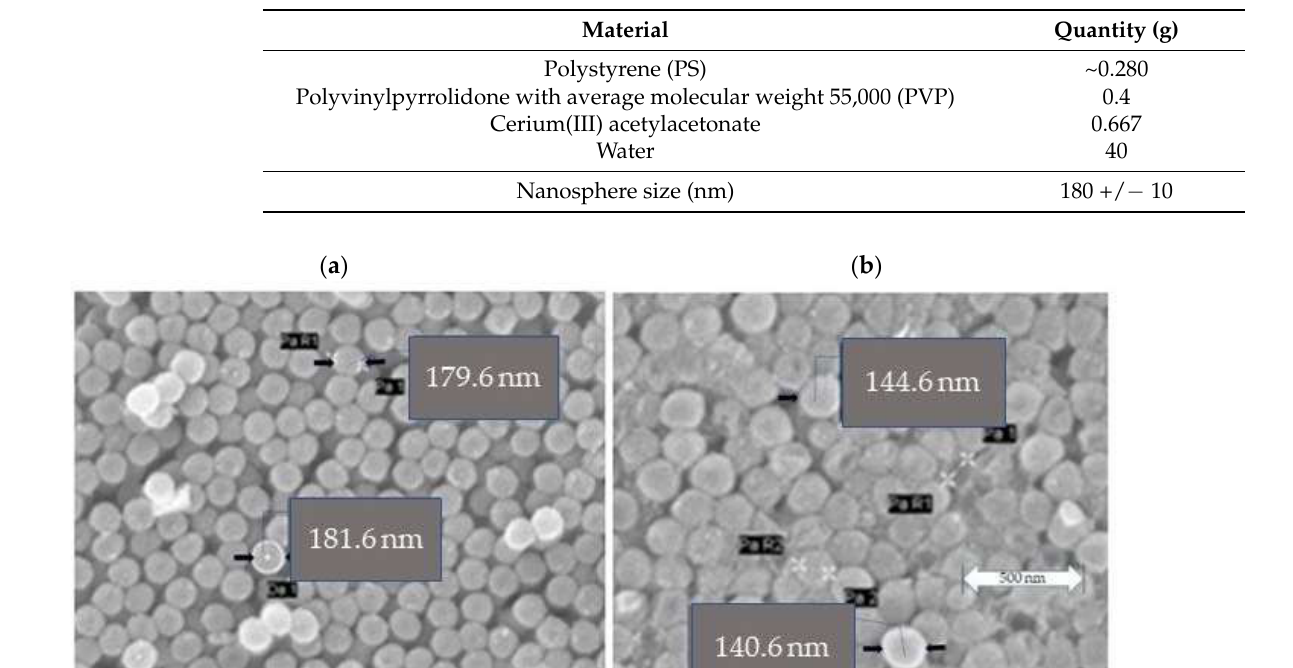
Table 2. The conditions used for the manufacture of coated polystyrene nanospheres. The size de- termined by TEM.